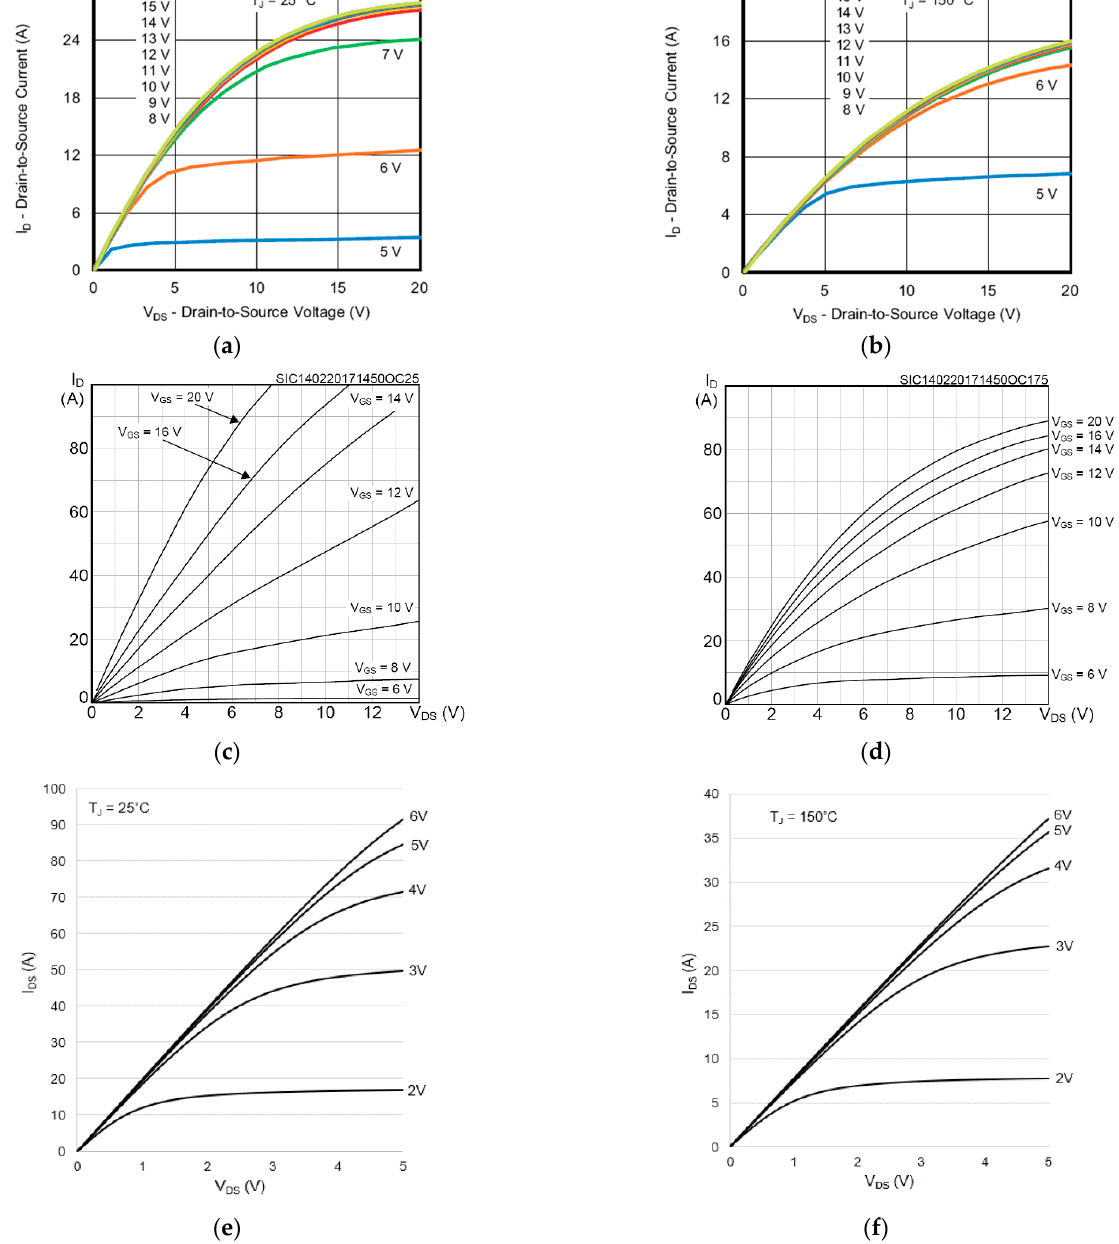
Figure 2. Output characteristics at 25 °C ( a , c , e ), 150 °C ( b , f ), and 175 °C ( d ). ( a – b ) Si MOSFET (Vishay SiHA15N80AEF) [35]; ( b – c ) SiC MOSFET (STMicroelectronics SCTL35N65G2V) [36]; ( e – f ) GaN HEMT (GaN System GS66508B) [37].